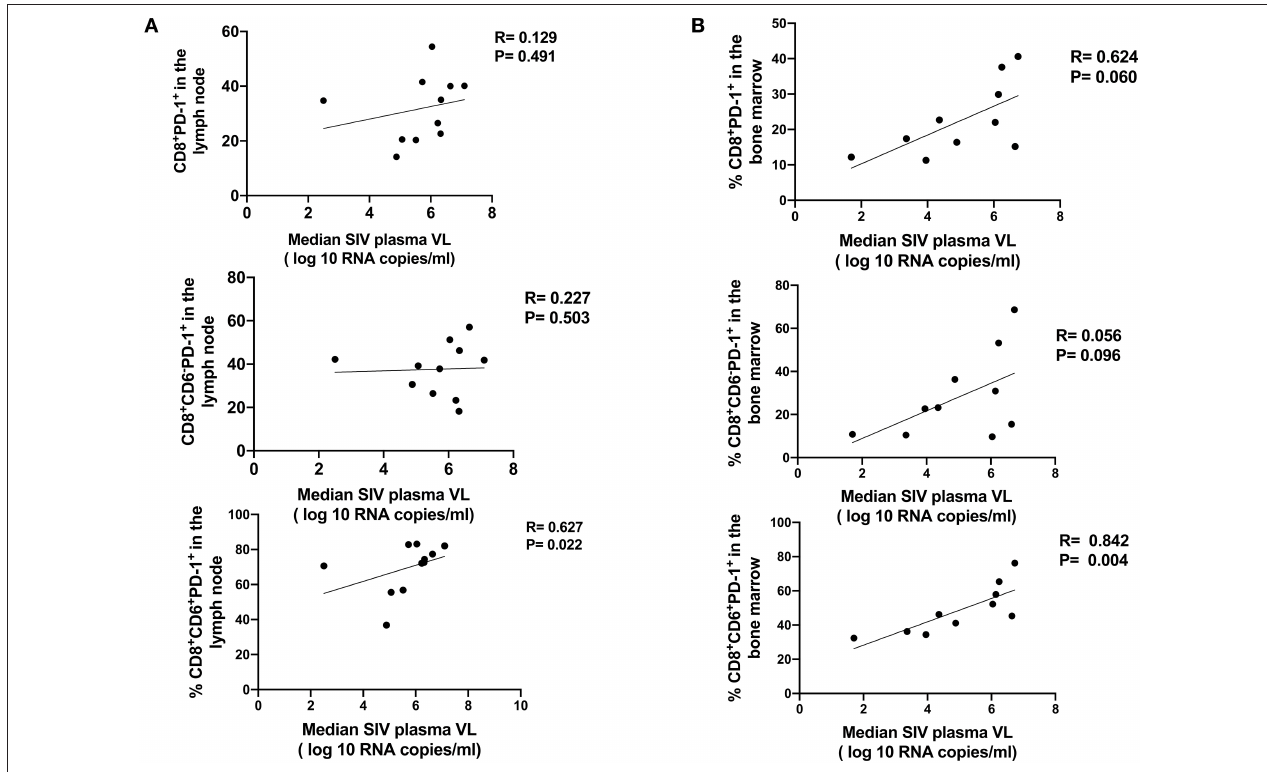
FIGURE 9 | Overexpression of CD6 and PD-1 on CD8 T-cells is associated with SIV disease progression. The correlation of CD8 + PD-1 + (Top), CD8 + CD6 − PD-1 + (Middle panel), CD8 + CD6 + PD-1 + (Bottom panel) T-cells in the (A) LN and (B) bone marrow with the median SIV plasma viral load (VL) over weeks 12–40 post-infection. Data are from 11 (lymph node) and 10 (bone marrow) macaques, respectively. For statistical analysis, the nonparametric spearman correlation was performed.